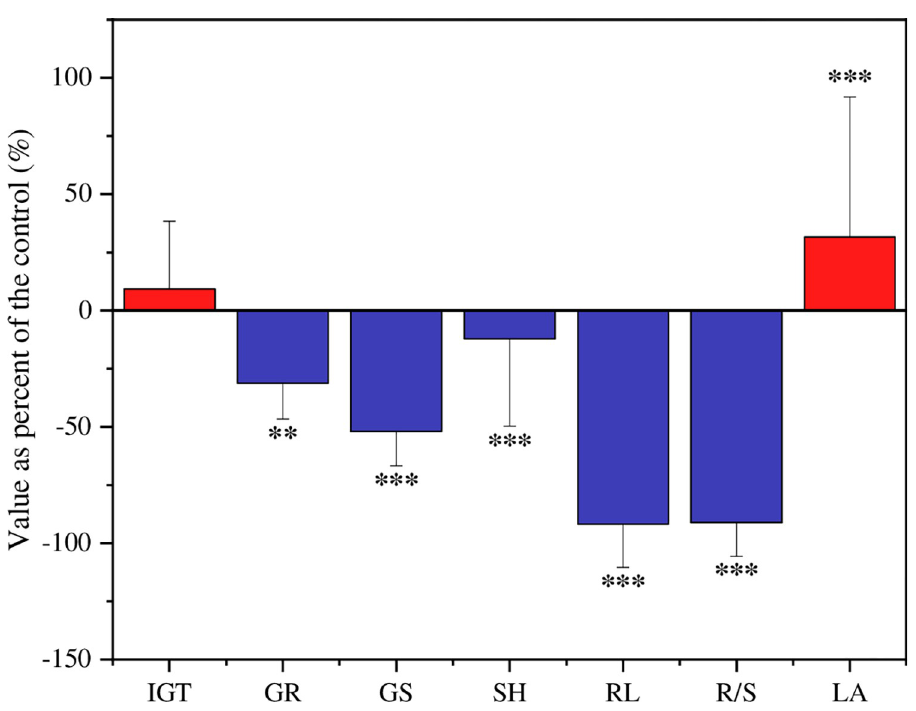
Fig 1. The seed germination and seedling growth indices of L . sativa treated with A . philoxeroides aqueous extracts. IGT, GR, GS, SH, RL, R/S and LA represent initial germination time, germination rate, germination speed, shoot height, root length, root length:shoot height ratio and leaf area, respectively. ‘ � ’, ‘ �� ’ and ‘ ��� ’ signify p < 0.05, p < 0.01 and p < 0.001 compared with the control,